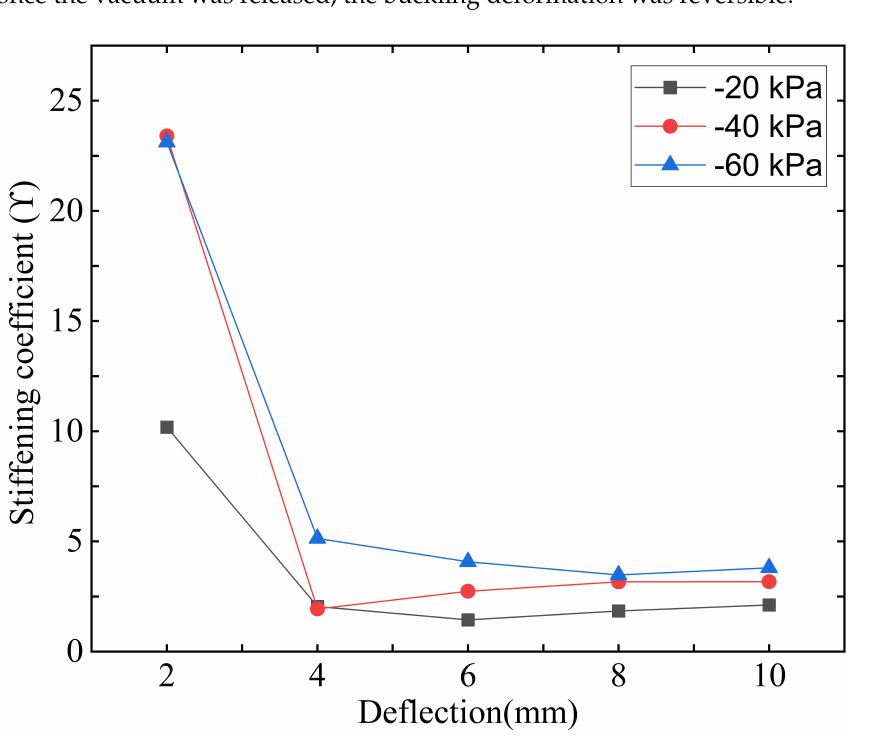
Figure 7. Stiffening coefficient γ for stiffening segment in the axial compression experiment under − 20 kPa to − 60 kPa